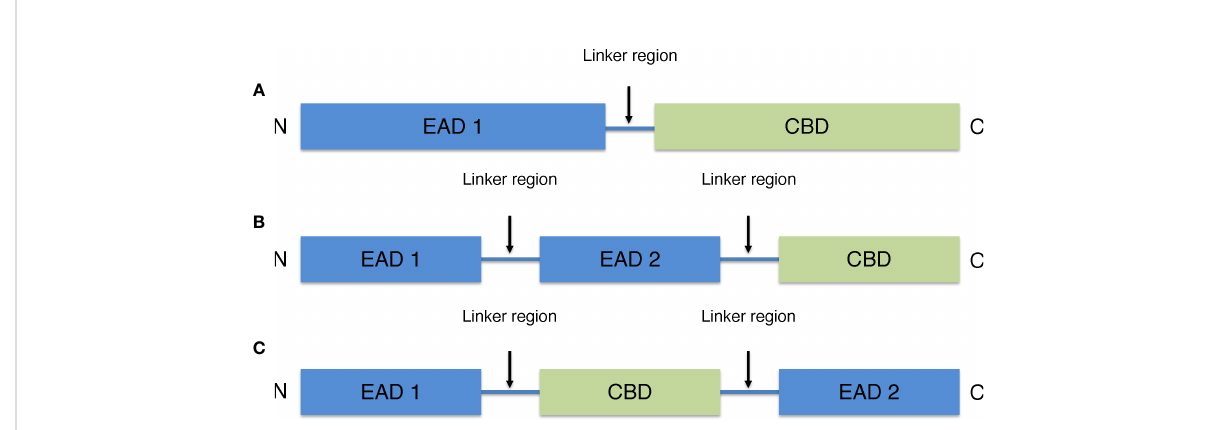
FIGURE 1 General schematic models of endolysins derived from phages that infects Gram-positive host. (A) Model with one N-terminal EAD and one C- terminal CBD. (B) Multi-domain model with two EAD and one C-terminal CBD. (C) Multi-domain model with one CBD located between two